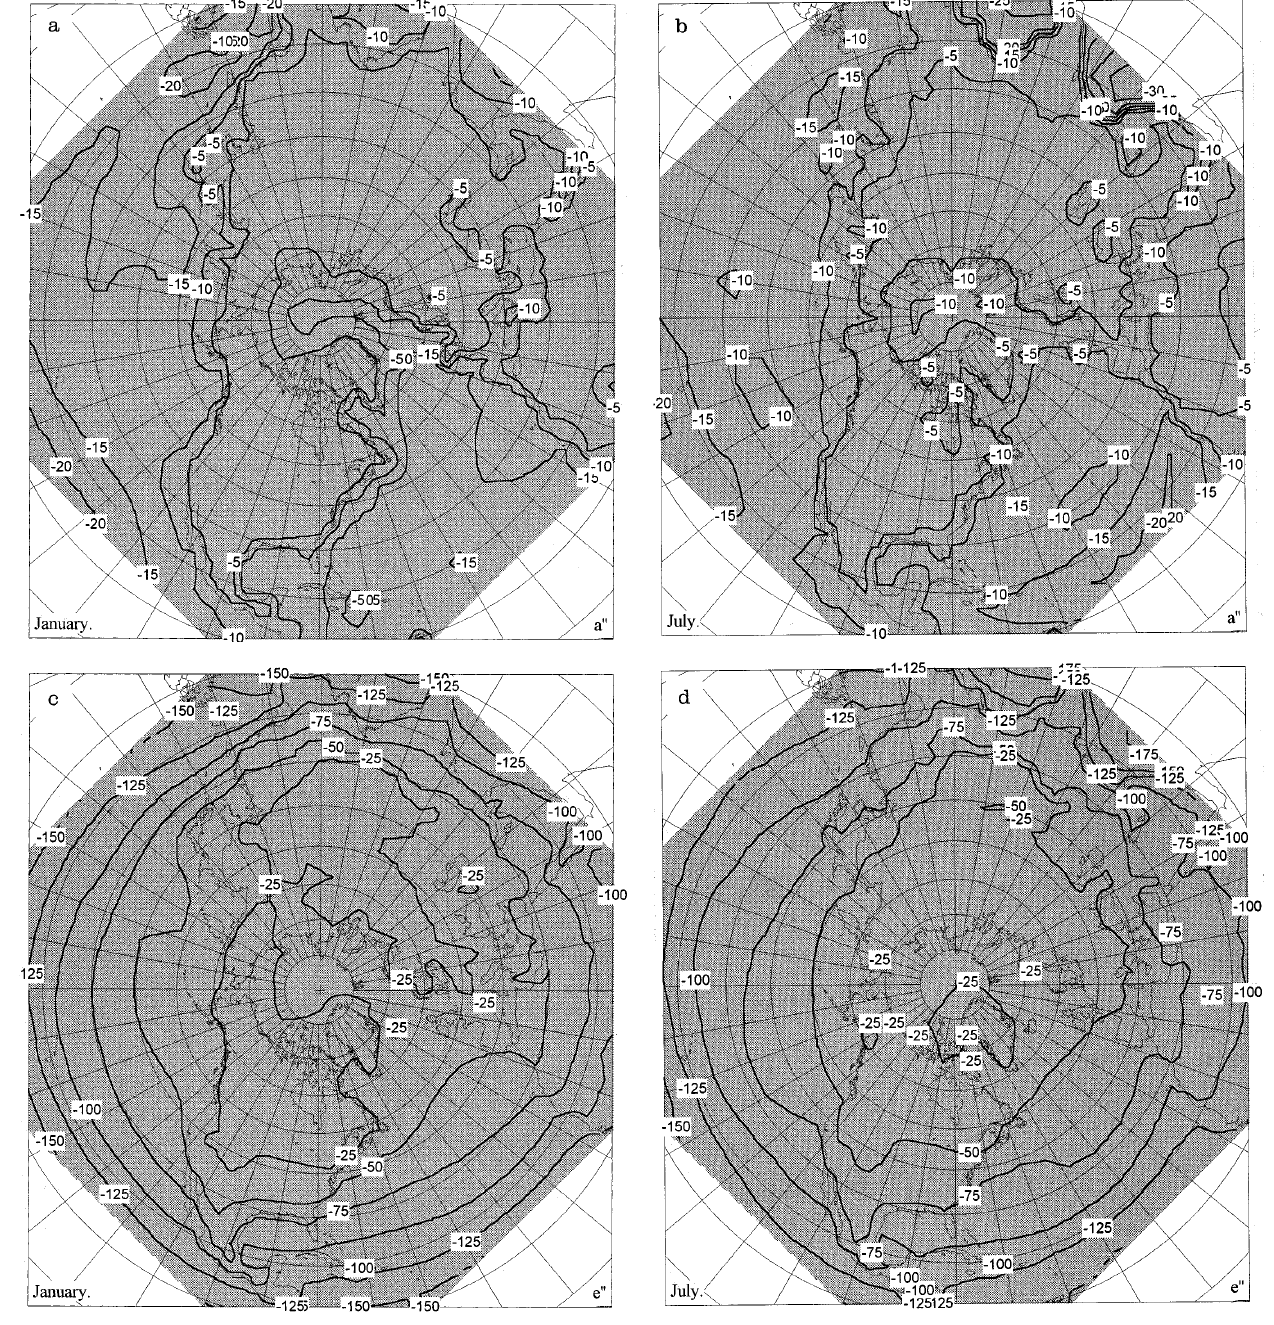
Fig. 5a–d. Geographical patterns of the a 00 and e 00 coe(cid:129)cients in the theoretical Eq. (46), computed in 2 Wm (cid:255) 2 K (cid:255) 1 . a Is the a 00 coe(cid:129)cient for winter, b the a 00 coe(cid:129)cient for summer, c the e 00 coe(cid:129)cient for winter, and d the e 00 coe(cid:129)cient